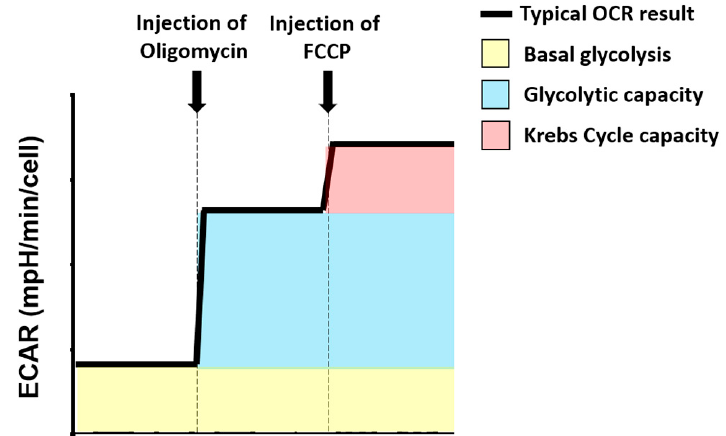
Figure 6. Use of the Extracellular Acidification Rate (ECAR) profile to calculate glycolysis-related metabolic parameters. Di ff erent colours have been used to represent the di ff erent ECAR parameters that have been calculated for these experiments. (yellow) represents basal glycolytic rate; (blue) represents glycolytic capacity; (red) indicates Krebs cycle capacity. A bolded black line shows the typical OCR profile. A dashed grey line indicated compound injection points.